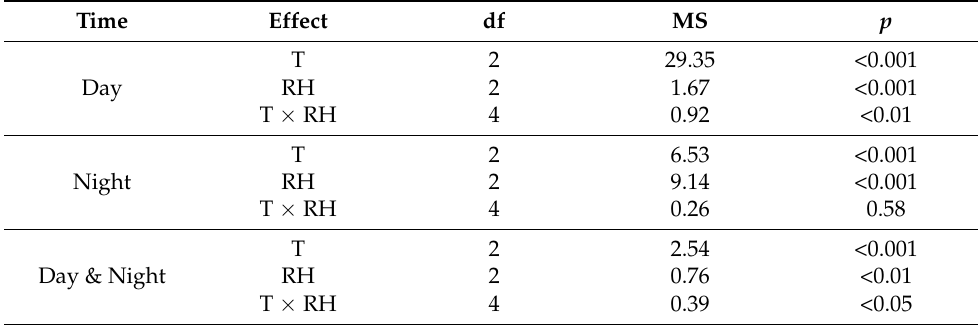
The leaf elongation rate during the day (LER Day ) varied between 0.50 mm h − 1 under Tinv/RHnat and 3.43 mm h − 1 under Tnat/RHcon (Figure 1). Temperature had a much larger effect on LER Day than RH, with a statistically significant interaction of the two factors (Table 2). LER Day was highest at Tnat, independent of RH, with an average of 3.25 mm h − 1 . At Tcon, LER Day varied between 1.64 (RHnat) and 2.51 mm h − 1 (RHinv), whereas at Tinv, it ranged from 0.50 (RHnat) to 1.49 mm h − 1 (RHinv). In the observed temperature range, LER Day increased linearly with day temperature at an average rate of 0.23 mm h − 1 ◦ C − 1 across RH treatments. Meanwhile, low RH during the day increased the temperature effect to 0.28 mm h − 1 ◦ C − 1 , and high RH during the day mitigated the effect to at 20 ◦ C to 2.22 mm h − 1 at 30 ◦ C, but a growing temperature of 30 ◦ C did not increase LER Day significantly in comparison to 25 ◦ C (Table 3). Table 2. Analysis of variance for leaf elongation rate during day, night and day & night under different day and night temperature and relative air humidity (RH) regimes around the same daily mean temperature (25 ◦ C) and RH (65%) in 3 replications. Abbreviations: T: temperature; d.f.: degree of freedom; MS: mean square.